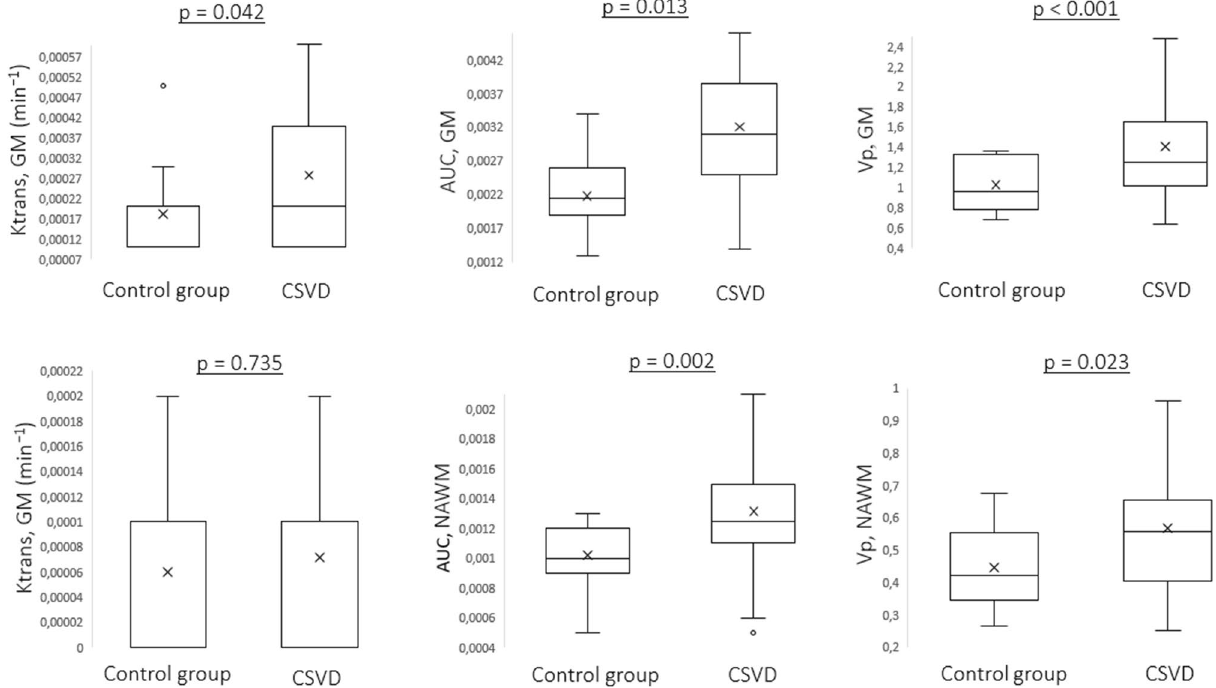
Figure 2. Differences in DCE-MRI parameters in patients with CSVD and